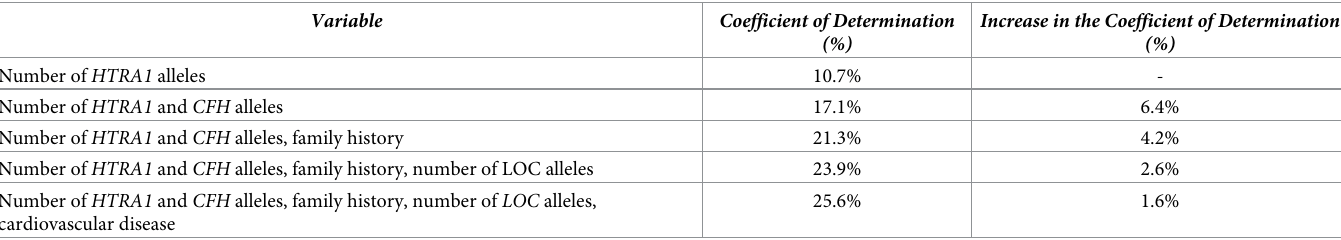
Table 4. Values of the coefficient of determination and its increment in descending order of importance of the independent variable to the determination of